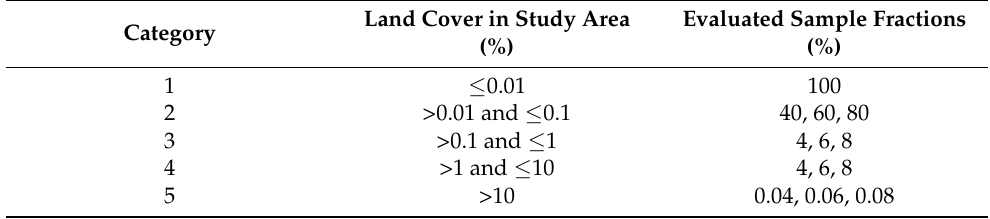
Table 2. Sampling categories based on GAP land cover class percent cover in the study area and the evaluated sample fractions for each